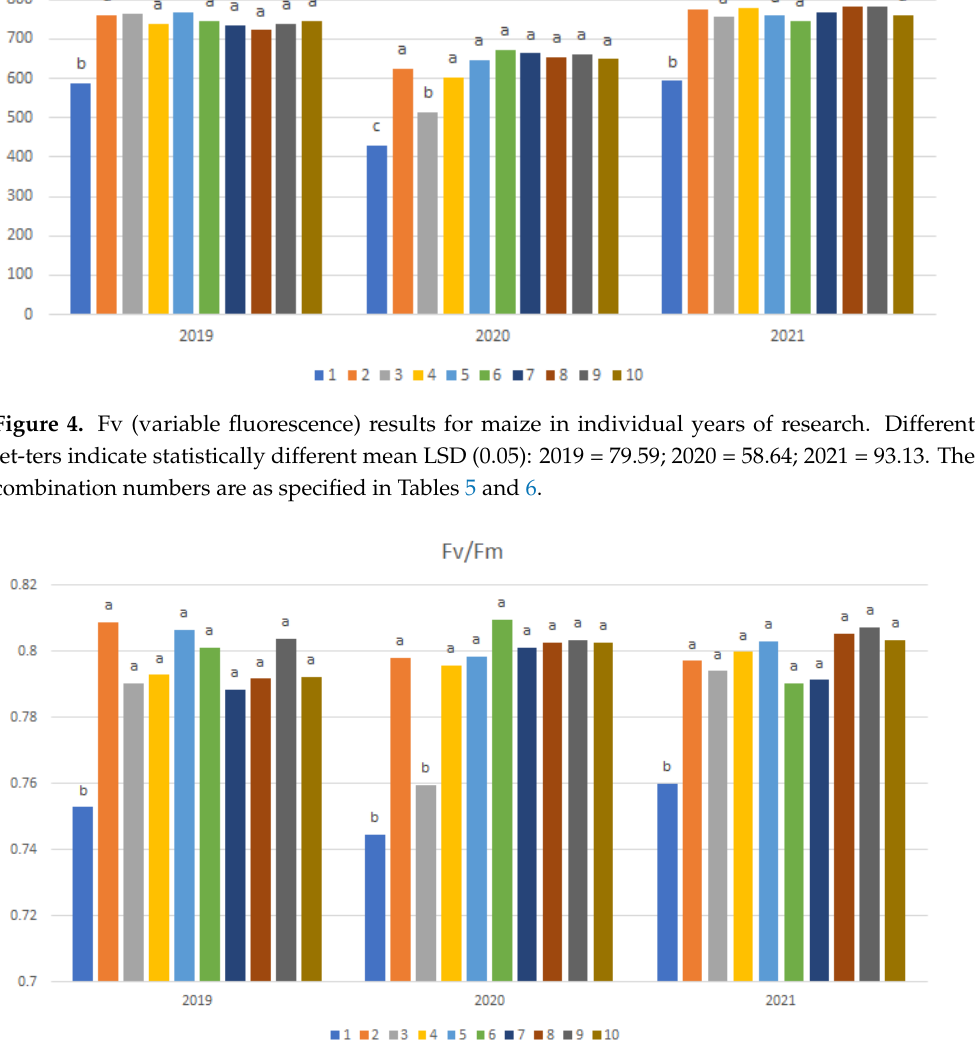
Figure 5. Fv/Fm (maximum photochemical efficiency of photosystem II) results for maize in individual years of research. Different letters indicate statistically different mean LSD (0.05): 2019 = 0.024; 2020 = 0.017; 2021 = 0.017. The combination numbers are as specified in Tables 5 and 6.